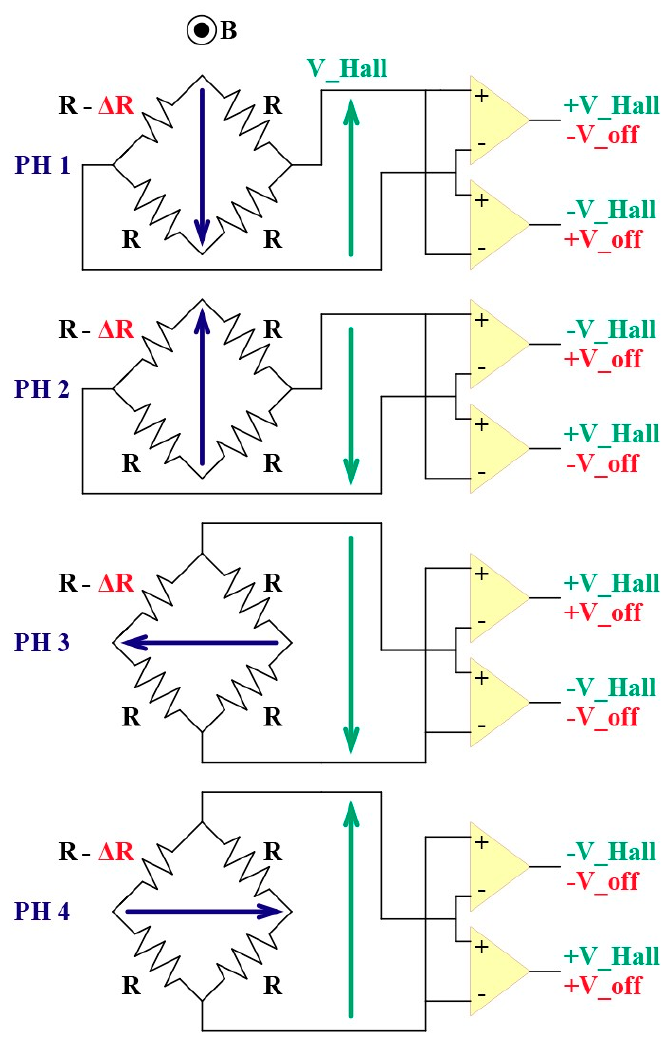
Figure 4. Four phase spinning current sequence. The inherent resistance imbalance in the Hall probe produces an offset voltage in which polarity does not follow that of the true Hall voltage, which depends only on the current direction. Therefore, this can be filtered out.